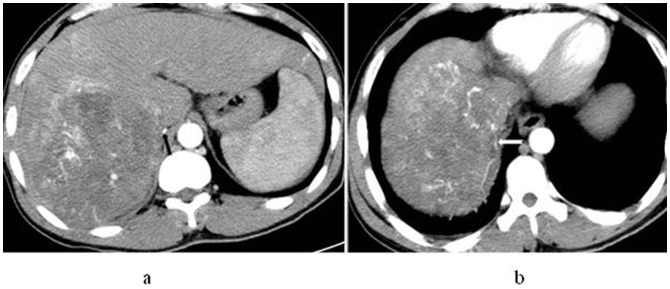
In a 52-year-old man with hepatocellular carcinoma in S7, right inferior phrenic artery participates in HCC blood supply for the tumour.Axial (a) and maximum intensity projection (b) images display the enlarged right inferior phrenic artery (black arrow) and its branches into the lesion (white arrow), respectively.